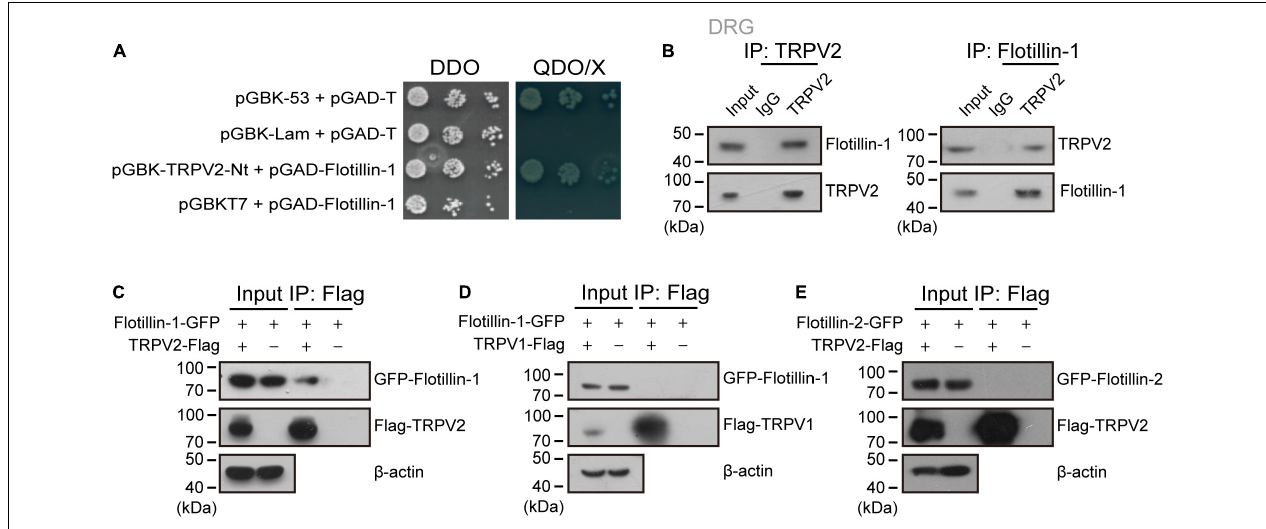
FIGURE 1 | Flotillin-1 physically interacts with TRPV2. (A) Yeast two-hybrid results showing the interaction between TRPV2 N-terminus (V2-Nt) and flotillin-1. The bait and prey constructs were co-transformed into yeast strain AH109, and the transformed yeast diploids were grown on DDO for 2 days and QDO for 5 days, respectively. The 53-T and Lam-T were served as positive and negative controls, respectively. DDO, SD-Leu/-Trp medium; QDO, SD-Leu/-Trp/-His/-Ade medium; X, X - α -gal. (B) Immunoprecipitation (with anti-TRPV2, anti-Flotillin-1, or IgG as a control) and immunoblot analysis (with anti-TRPV2 or anti-Flotillin-1) of the mouse DRG neurons. (C) Interaction between flotillin-1 and TRPV2. HEK 293T cells were transfected with plasmids as indicated. Immunoprecipitation (IP, with anti-Flag) and immunoblot analysis (with anti-GFP and anti-Flag) of the interaction between TRPV2 and flotillin-1. (D) No interaction between flotillin-1 and TRPV1. Immunoprecipitation (with anti-Flag) and immunoblot analysis (with anti-GFP and anti-Flag) of HEK 293T cells transfected with plasmids encoding Flag-tagged TRPV1 and GFP-tagged flotillin-1. (E) No interaction between TRPV2 and flotillin-2. Immunoprecipitation (with anti-Flag) and immunoblot analysis (with anti-GFP and anti-Flag) of HEK 293T cells transfected with plasmids encoding Flag-tagged TRPV2 and GFP-tagged flotillin-2. Data are representative of three independent experiments at